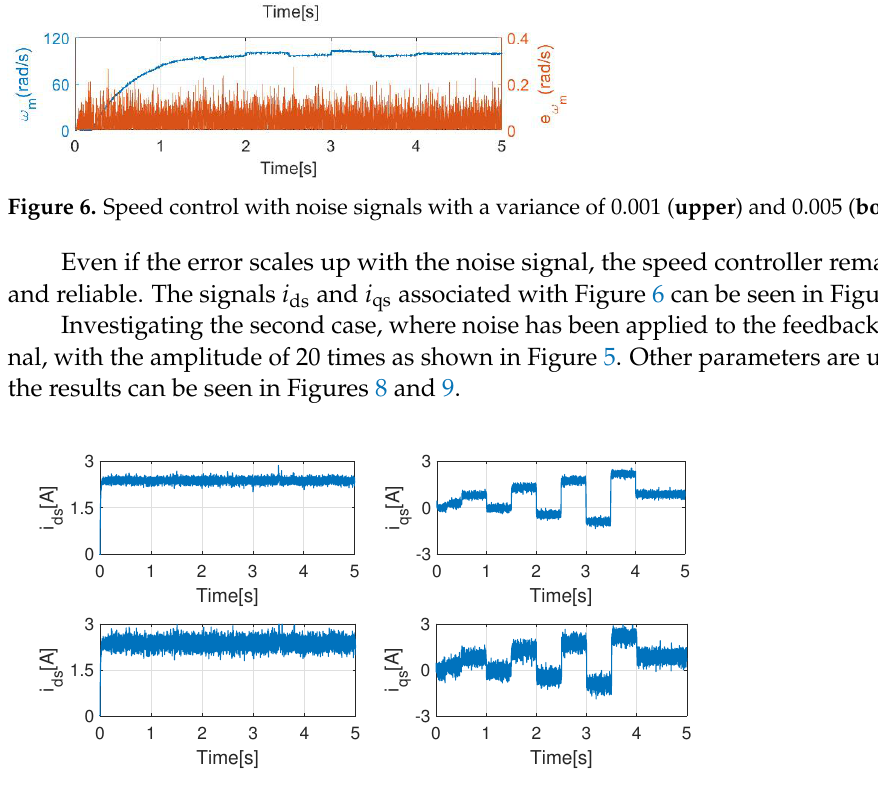
Figure 7. Current curves with noise signals with a variance of 0.001 ( upper ) and 0.005 ( bottom